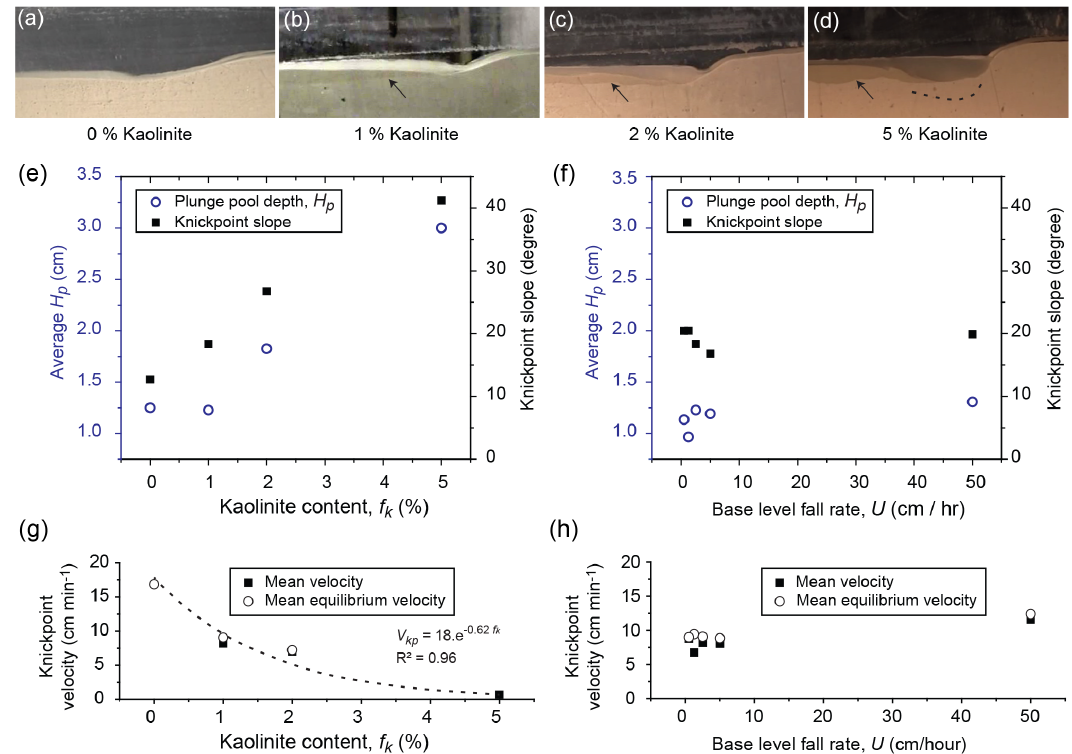
Figure 8. Knickpoint characteristics as a function of base-level fall rate and substrate. (a) – (d) Illustrations of the knickpoint shapes as a function of the kaolinite content ( f k ) in the substrate. Note that the plunge pool depth could not be measured from photographs for experiment 11 ( (d) ; f k = 5%): the substrate was so cohesive that it stuck on the walls and the bottom of the plunge pool was not accessible. H p was, however, estimated to be ca. 3cm on the flume during experiment 11. In this experiment, the geometry of the bed was more heterogeneous and the channel narrowed to incise the bedrock. The dashed line corresponds to the approximate bottom on the plunge pool. (e) Variations in knickpoint slope and plunge pool depth as a function of f k . (f) Variations in knickpoint slope and plunge pool depth as a function of the base-level fall rate, U . (g) Mean knickpoint retreat velocity shown as a function of f k . The exponential fit is represented with a dashed line. (h) Mean knickpoint retreat velocity shown as a function of U